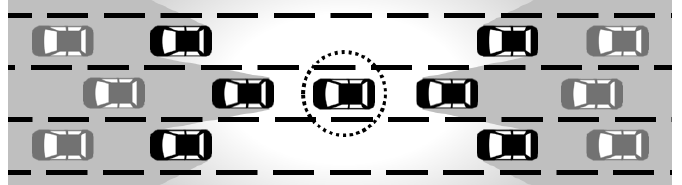
Figure 2. An illustration of available gaps for lane change. The circled vehicle is host vehicle V H , the bright area around it is available gaps. The gray area is the blind zone which is unavailable